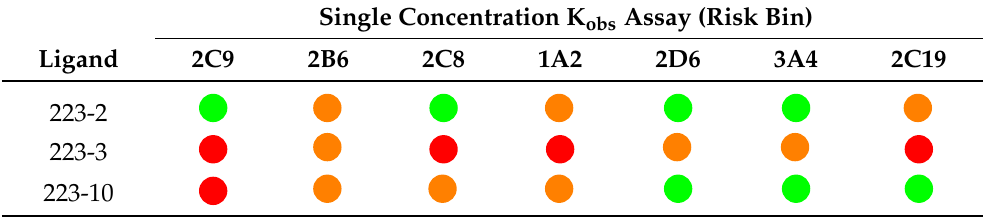
Table 5. Single concentration K obs assay of TbB ligands. A K obs value of 0.02 min − 1 is a good indicator of TDI potential. The same is presented in the table as a traffic light indicator, with green color representing negative inhibition, orange representing weak positive inhibition, and red representing positive inhibition. Based on the Single concentration K obs assay, the TD inhibition potential of the ligands can be expressed as 223-3> 223-10> 223-2. Therefore, 223-2 is a weak TD inhibitor.